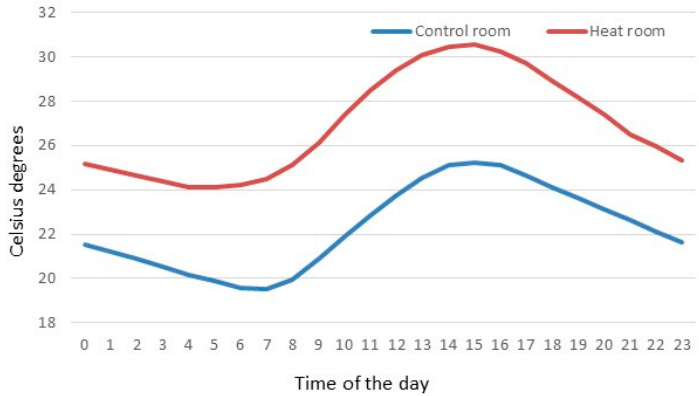
Figure 1. Average temperatures from 00:00 h to 23:00 h for control and heat rooms along the study.